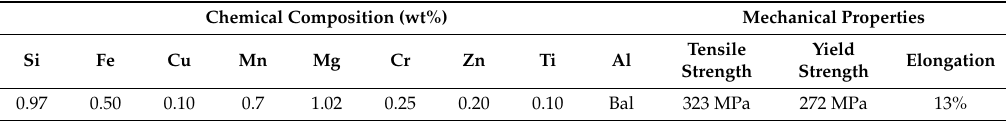
Table 1. Chemical composition and mechanical properties of 6082-T6 aluminum alloy. Chemical Composition